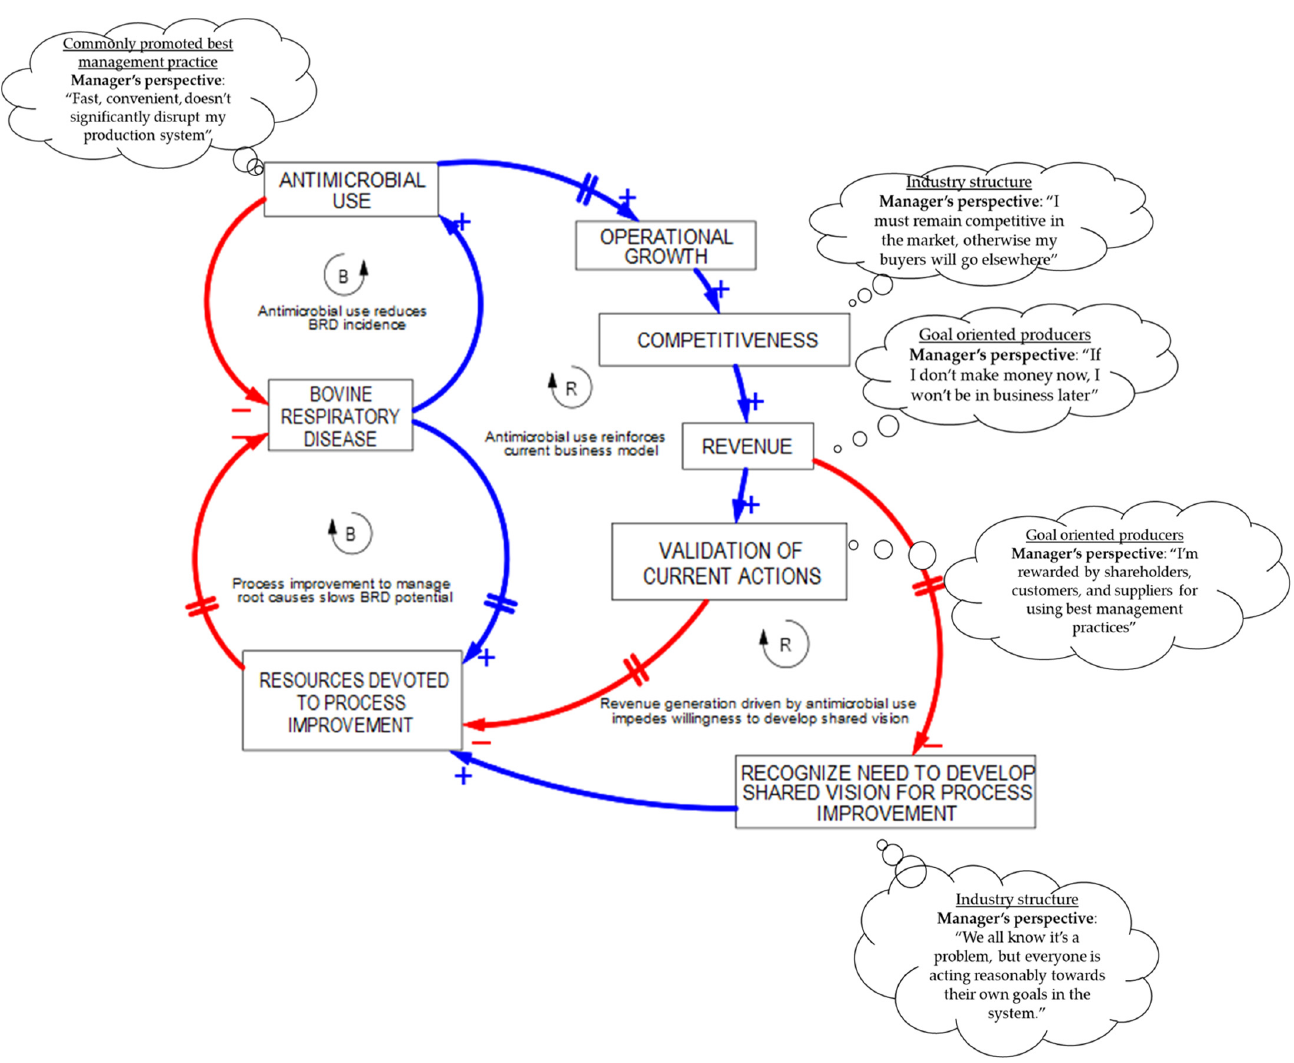
Figure 6. “ Shifting the Burden” causal loop diagram with two reinforcing loops representing the side-effects of antimicrobial use on growth and revenue long-term and, therefore, willingness to recognize the need to develop a shared vision.